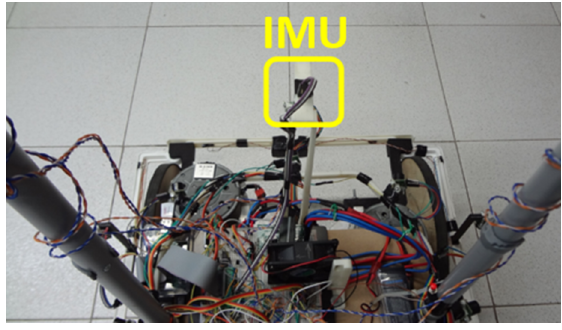
Figure 4. Inertial measure unit ( IMU) sensor in prototype.